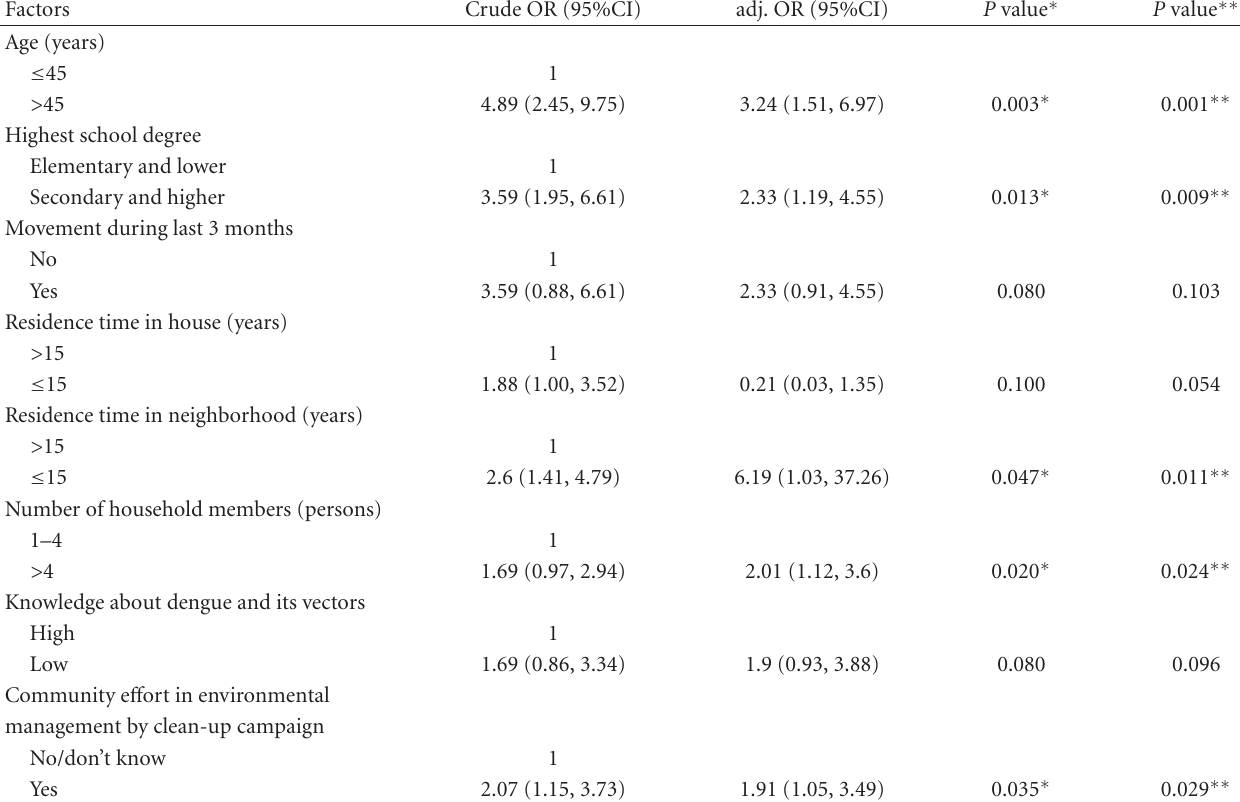
Table 4: Multivariate analysis of the association between sociodemographic factors of respondents and dengue